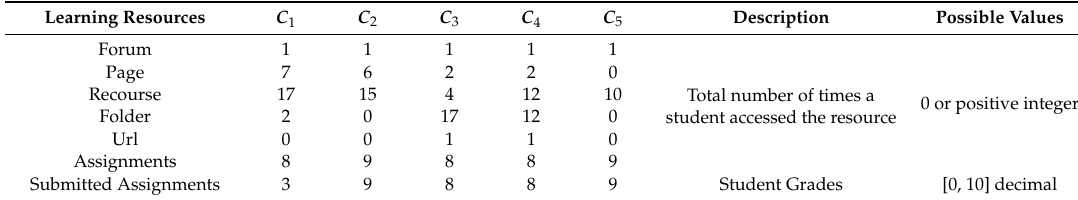
Table 2. Features extracted from students’ low-level interaction